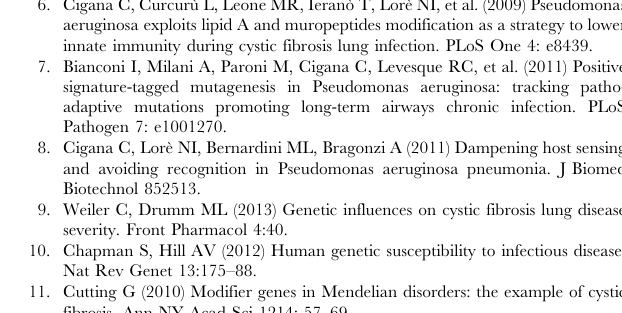
Table S4 Statistical comparison of survival between inbred mice infected with 5 6 10 5 P . aeruginosa. Table S5 Statistical comparison of Mean Survival time between inbred mice infected with 5 6 10 5 P . aeruginosa Table S6 Statistical comparison of change in body weight between inbred mice infected with 5 6 10 5 P